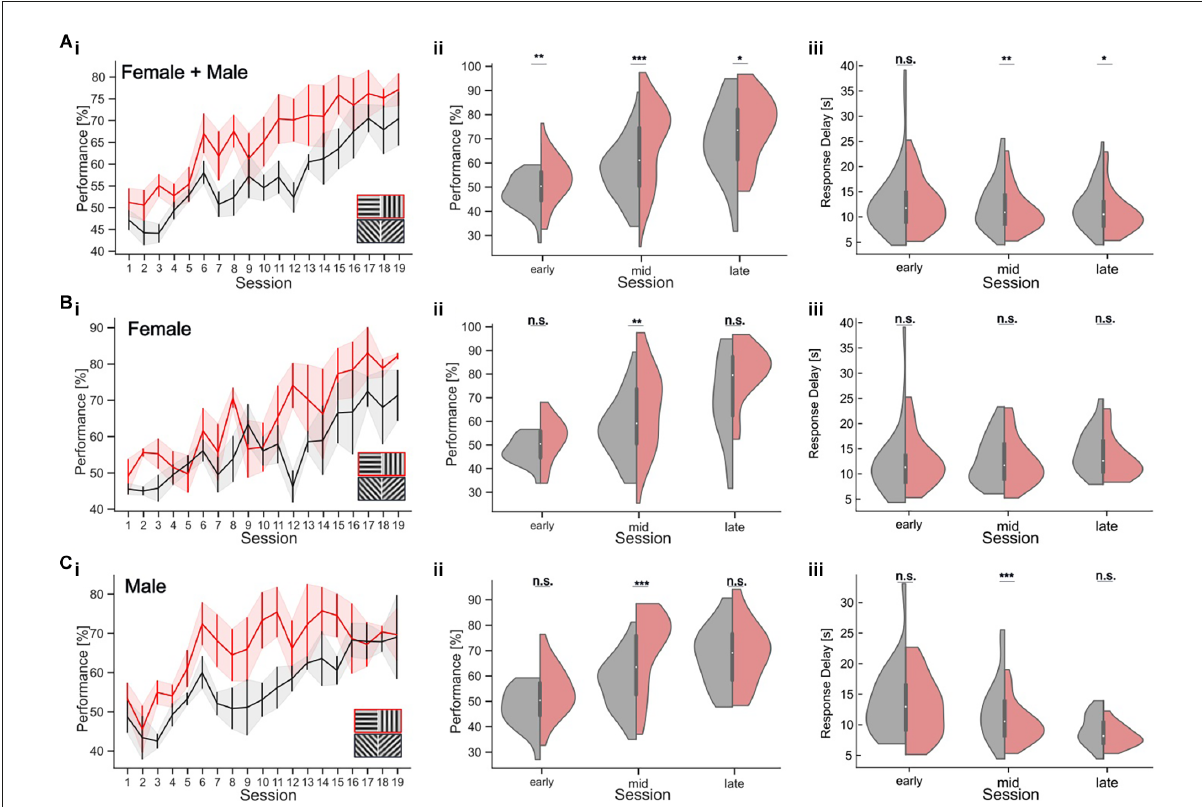
FIGURE6 Orientation discrimination with a parallel visual discrimination task. Cardinal or oblique stimuli are shown in randomized order across trials. Trials with a cardinal target also had cardinal distractor, while oblique targets were shown with an oblique distractor at a constant orientation difference of 90 ◦ . (A) (i) Performance over sessions ( n = 8 mice). The learning curves for the cardinal (red) and oblique stimuli (black) show the mean performance per session across all mice. Shaded areas indicate the SEM. The inset shows the two stimulus pairs. (ii) Performance in early, middle, and late periods of learning, for cardinal (red) and oblique (gray) stimuli for all mice. (iii) Response delay in early, middle, and late trials for cardinal (red) and oblique (gray) stimuli for all mice. (Bi–iii) Task performance and response delay for female mice only ( n = 4 mice). Conventions as in (A) . (Ci–iii) Task performance and response delay for male mice only ( n = 4 mice). Conventions as in (A) . * p < 0.05, ** p < 0.01, *** p < 0.001. No significant results are indicated by “n.s.” ( p = >